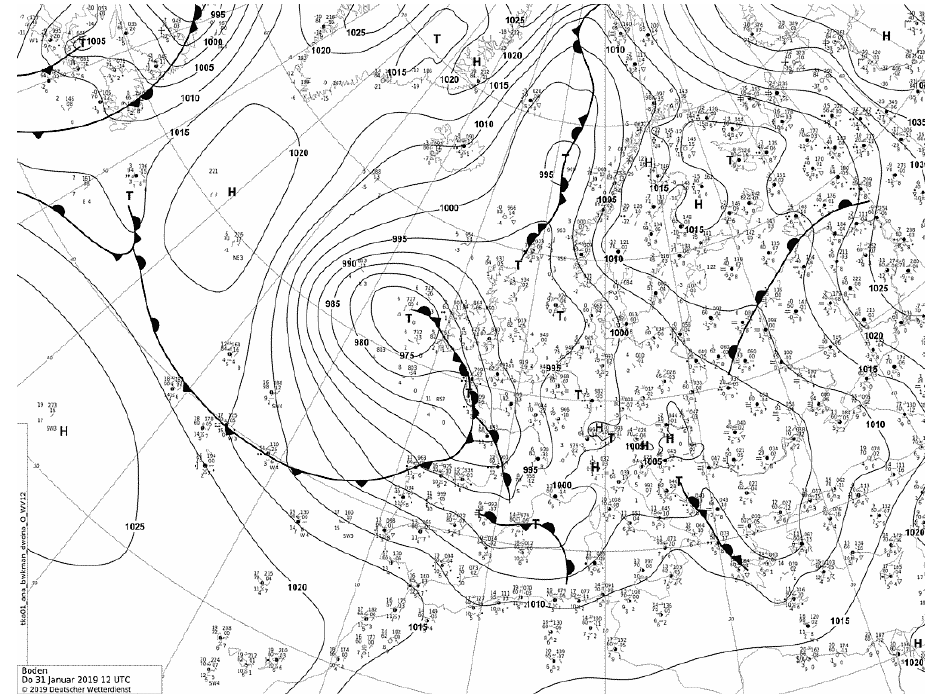
Figure 4. Original DWD map for 12 UTC, 31 January 2019.